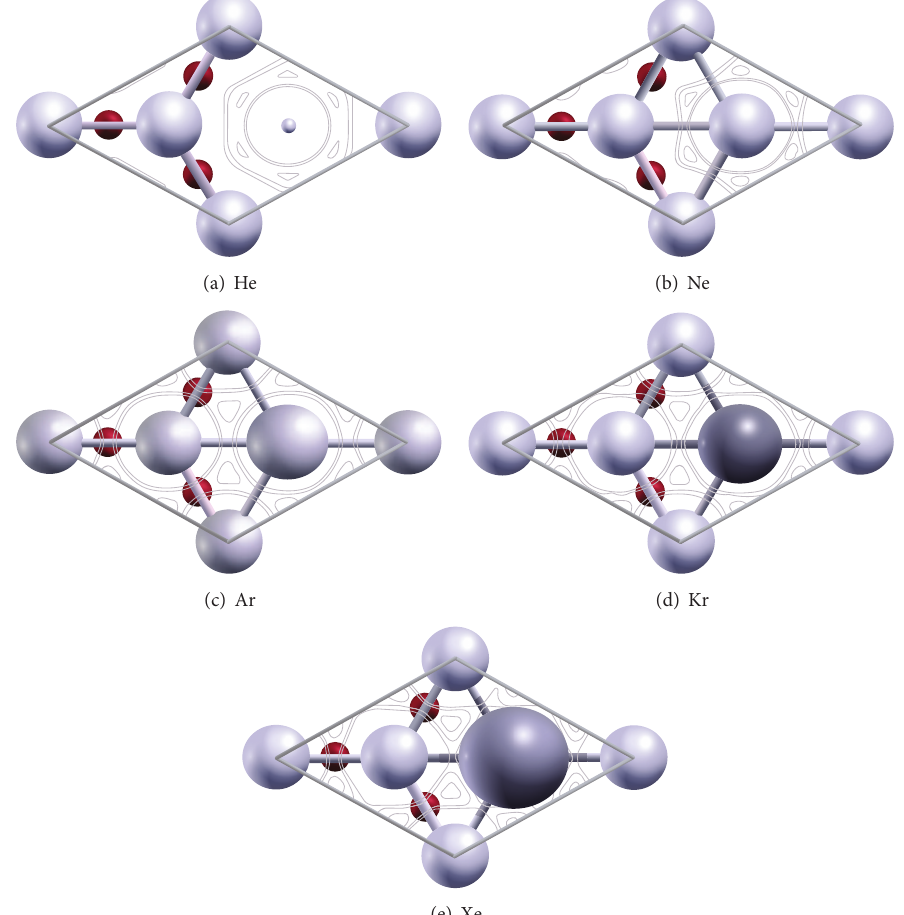
Figure 3: Electric charge density of rare gas atoms adsorbed on silver aluminosilicate.